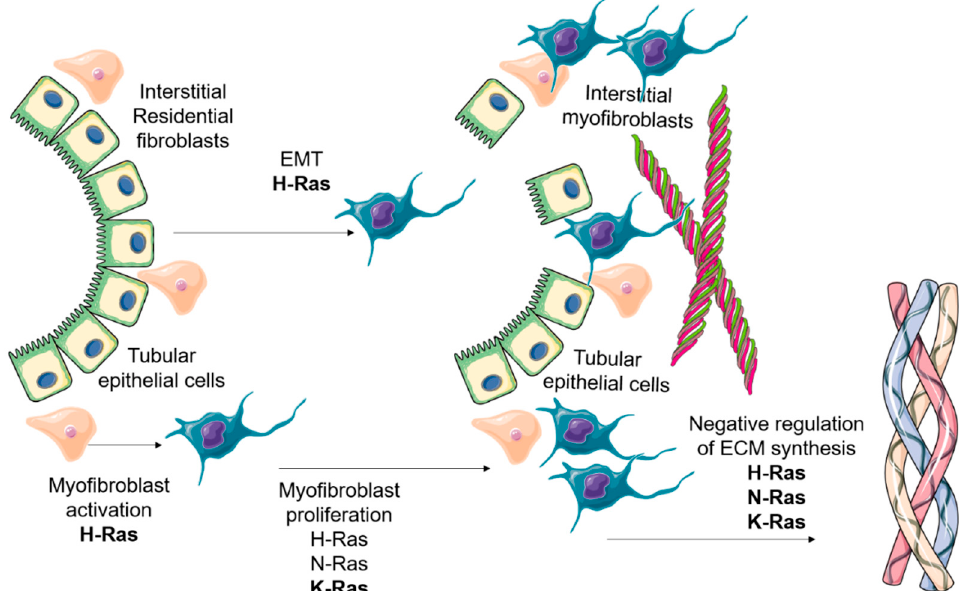
Figure 3. The overall role of Ras isoforms in kidney fibrosis development. As stated above, the main role of Ras isoforms in kidney fibrosis is the promotion of an increase in myofibroblast abundance in the tubular interstitium. The main source of myofibroblasts in this pathological scenario is the local resident fibroblasts and other mesenchymal cells. H, N and particularly K-Ras are involved in myofibroblast proliferation. Several studies have shown the role of H-Ras in the activation of myofibroblasts, due to its regulation of the EMT program. Once expressed in activated myofibroblasts, H, N and K-Ras foster a negative regulation on ECM proteins synthesis. On the left side, we show tubular epithelial cells which undergo EMT after the profibrotic stimuli. At the same time, myofibroblasts are activated in the tubular interstitium and proliferate to synthesize high amounts of ECM proteins, which are accumulated in the tubular interstitium (represented on the right side).